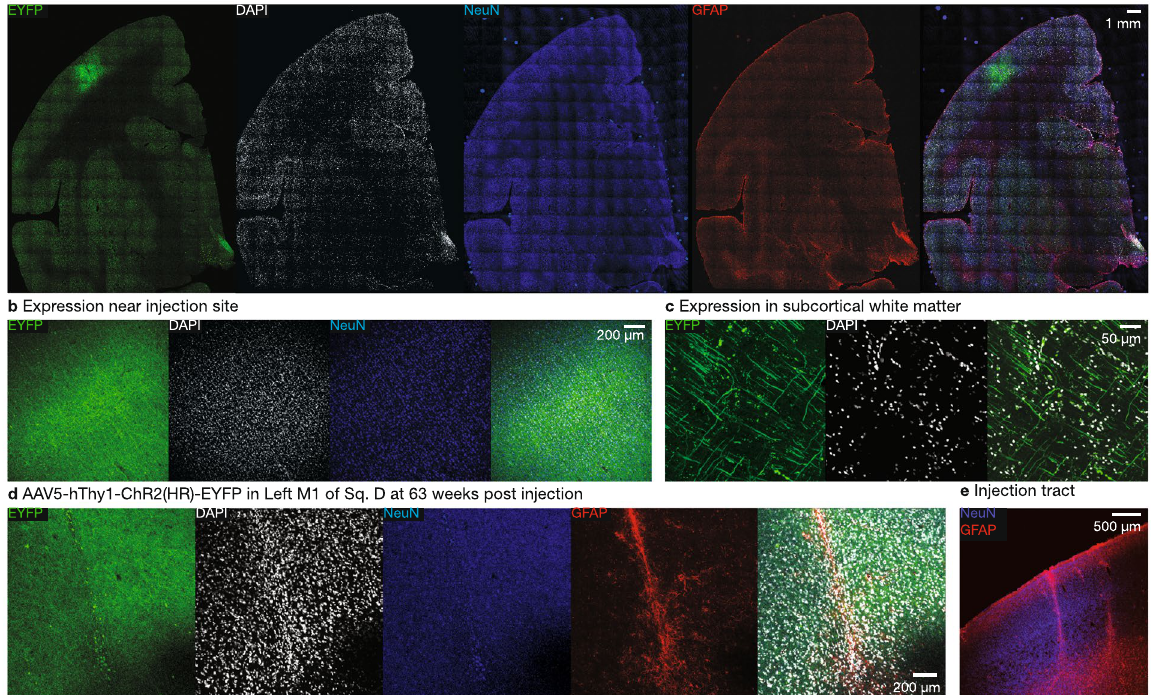
Figure 7. Long-term opsin expression in squirrel monkeys. ( a ) Expression of AAV5-hThy1-ChR2(H134R)- EYFP at 63 weeks post-injection in Sq. H in half coronal slice located near injection site in left M1. Low GFAP expression suggests minimal gliosis. ( b ) Expression in cell bodies of neurons located near injection site and ( c ) in crossing axonal fibers in subcortical white matter. ( d ) Expression of AAV5-hThy1-ChR2(H134R)-EYFP at 63 weeks post-injection in Sq. D left M1. ( e ) Gliosis was limited to the immediate vicinity of the injection track.